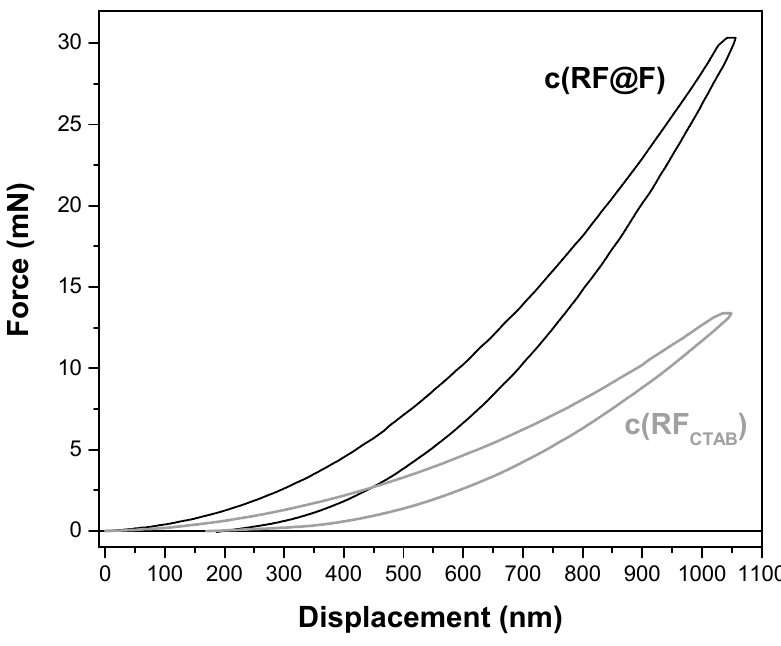
Figure 2. Nanoindentation profiles of hierarchical c(RF@F) (black line) and mesoporous c(RF CTAB ) (gray line).